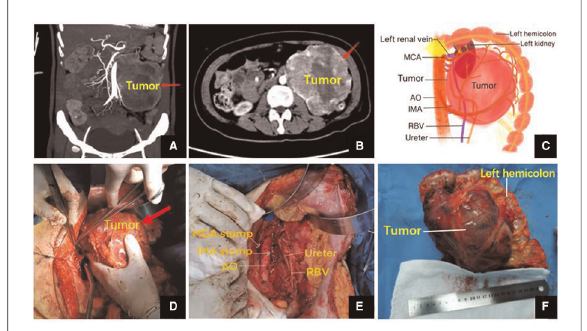
FIGURE 1 ( A,B ) Abdominal coronal and horizontal CT. ( C ) Postoperative surgical drawing. ( D,E ) Operative photos. ( F ) Gross examination revealed an encapsulated elliptic mass (17.0 cm×13.1 cm× 10.7 cm). MCA, middle colic artery; AO, aorta abdominalis; IMA, inferior mesenteric artery; RBV, reproductive blood